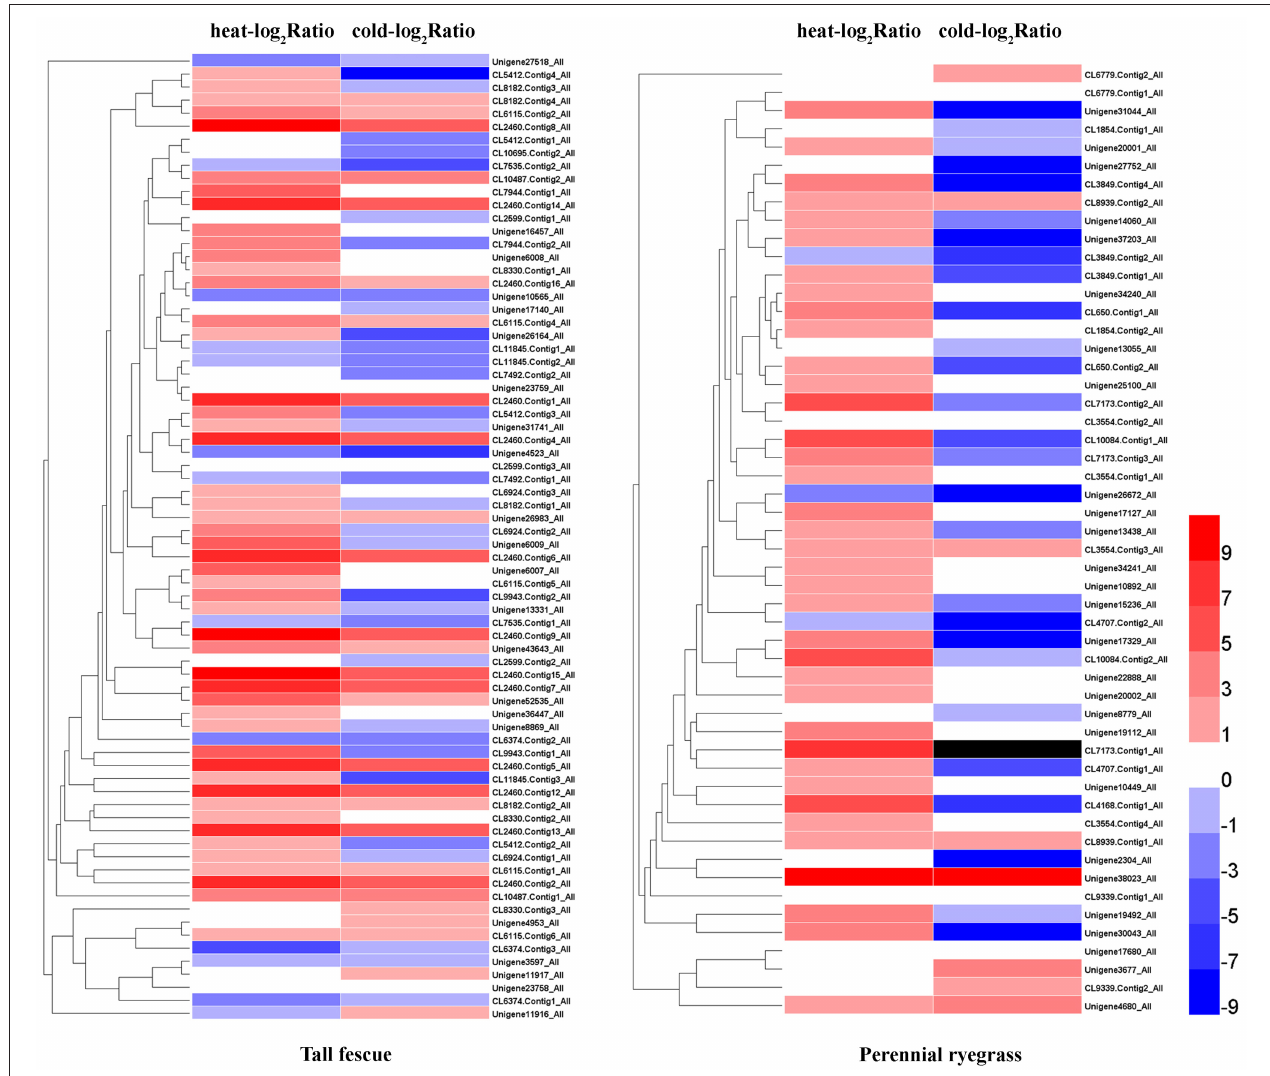
FIGURE 3 | Heatmaps of the expression profiles of Hsf genes in the two grass species subjected to heat and cold stress. Heat-log 2 Ratio indicates the fold-change of Hsf FPKM values under HS, and cold-log 2 Ratio represents the fold-change of Hsf FPKM values under CS. The black grid denotes genes where we did not detect